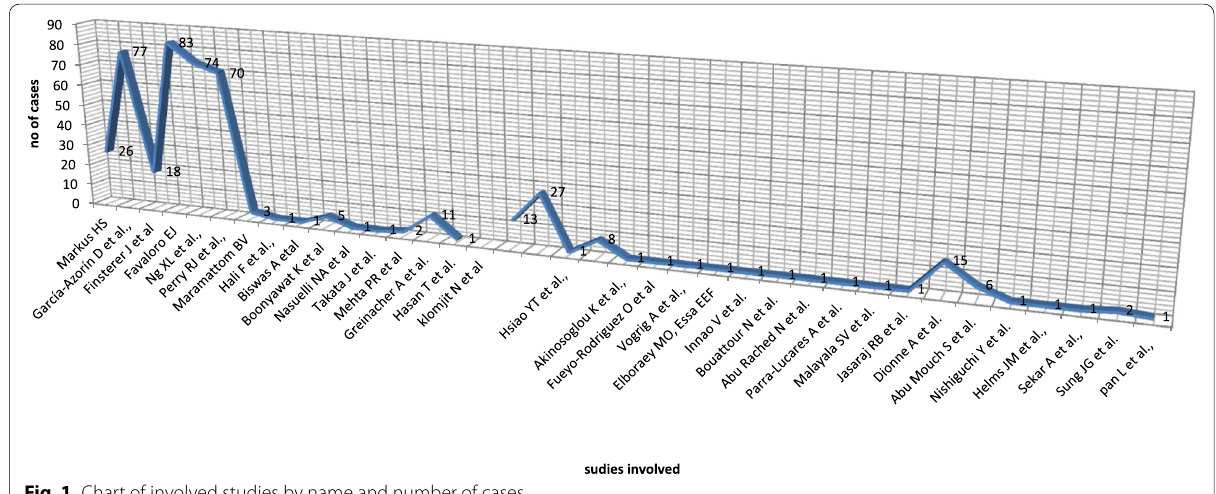
Fig. 1 Chart of involved studies by name and number of